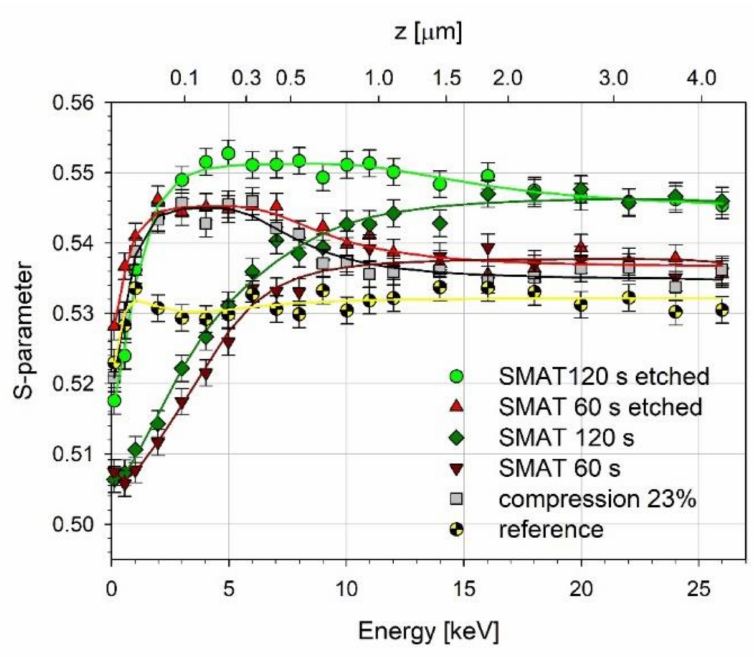
Figure 5. The S -parameter as a function of incident positron energy (mean implantation